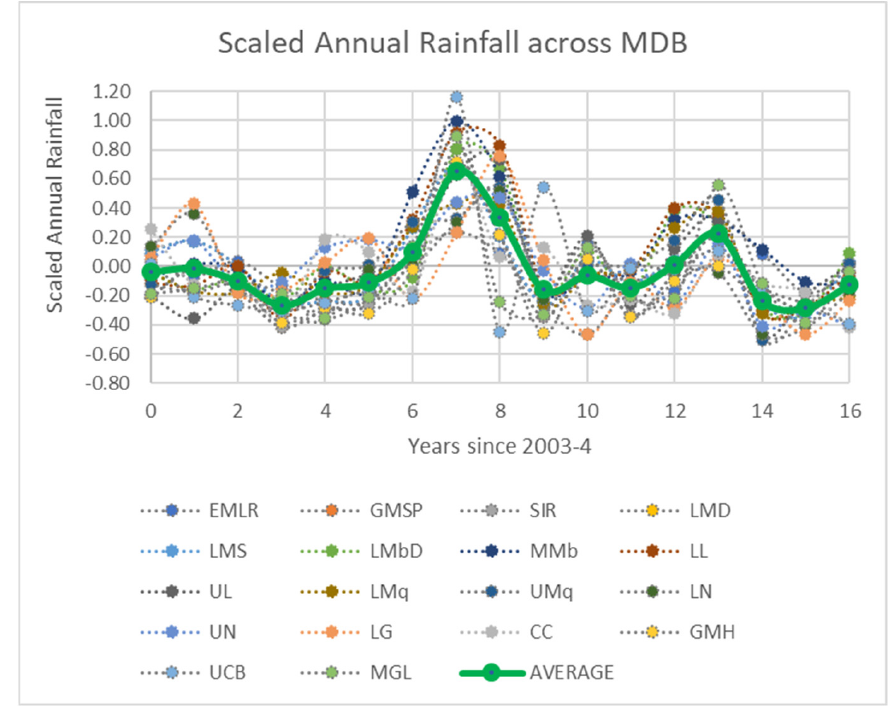
Figure 4. Scaled annual rainfall across the MDB and for each unit since 2003-2004.